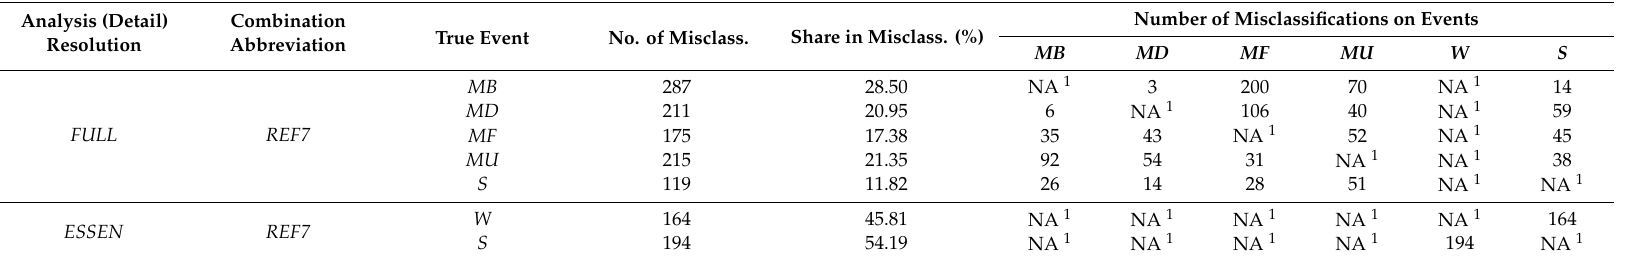
Table 7. Misclassifications in the best